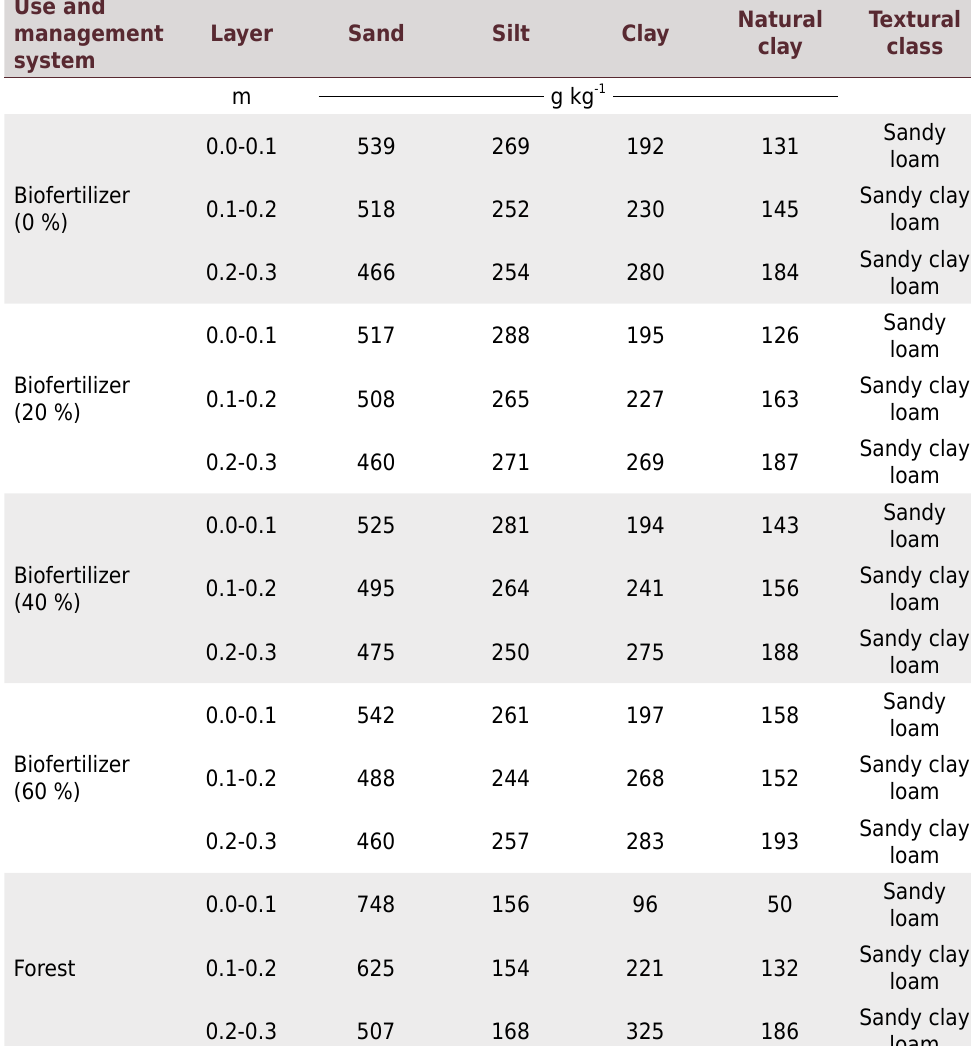
Table 1. Soil physical characteristics Use